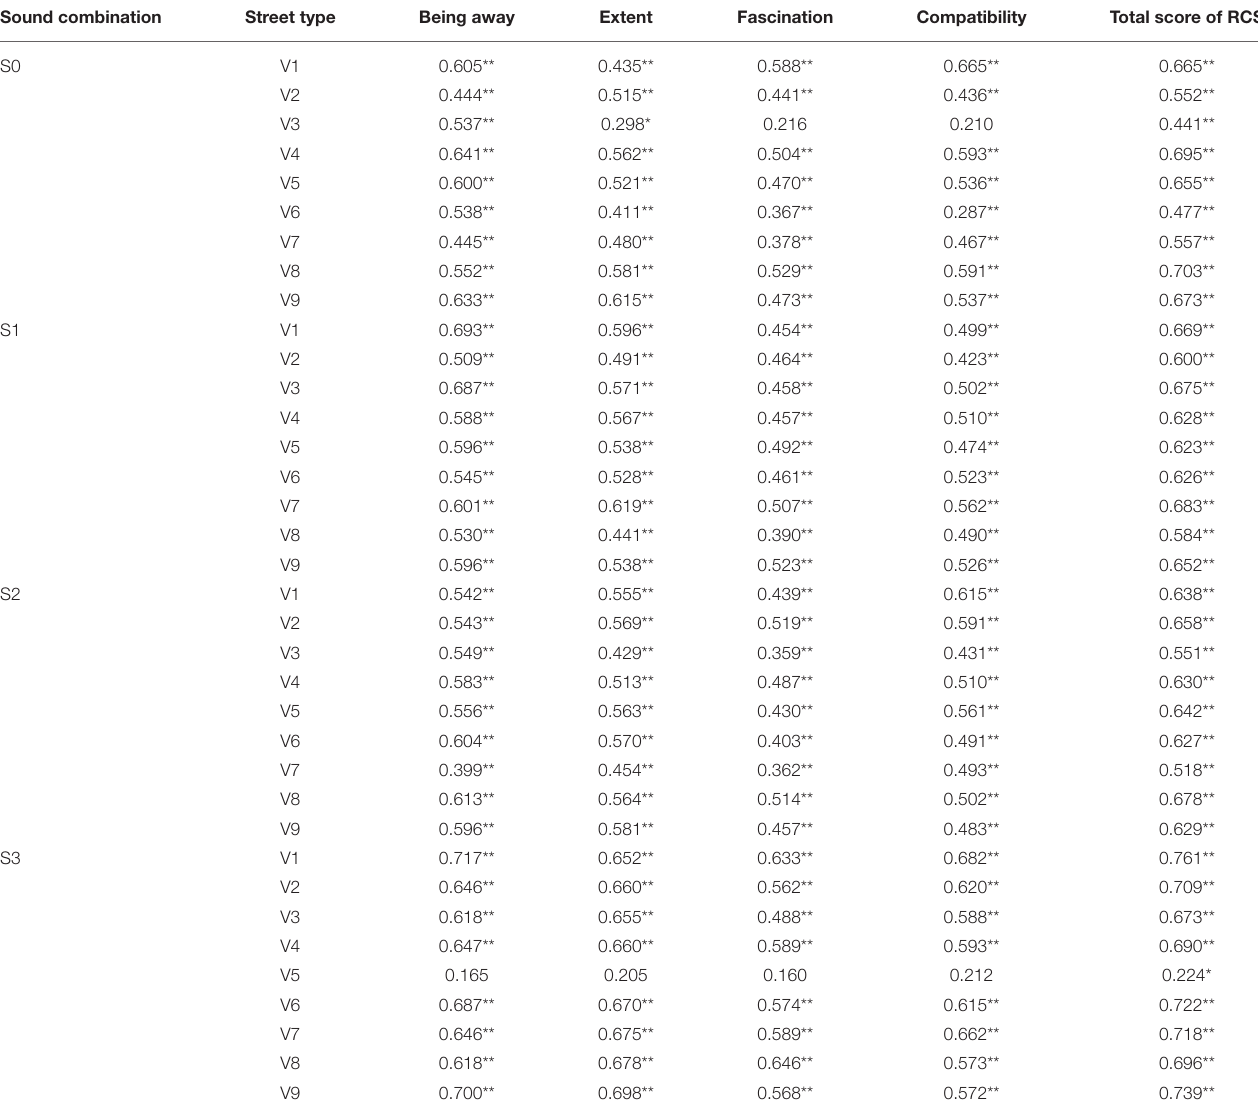
TABLE 3 | Pearson’s correlation results between VAQ and evaluation of